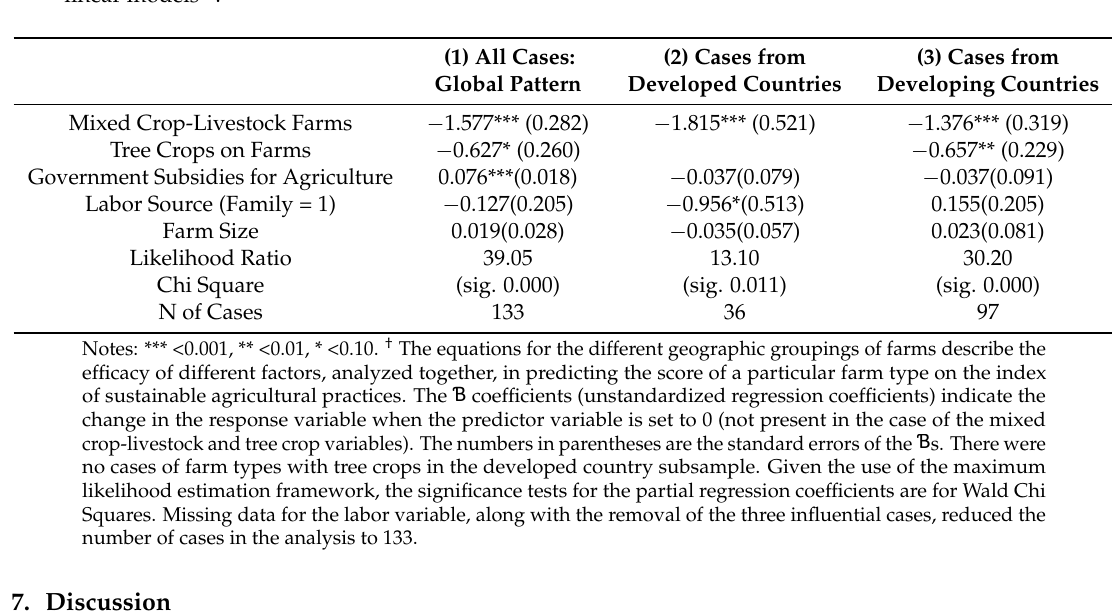
Table 3. Variations in sustainable agriculture practices across farm types: Ɓ coefficients from generalized linear models † .